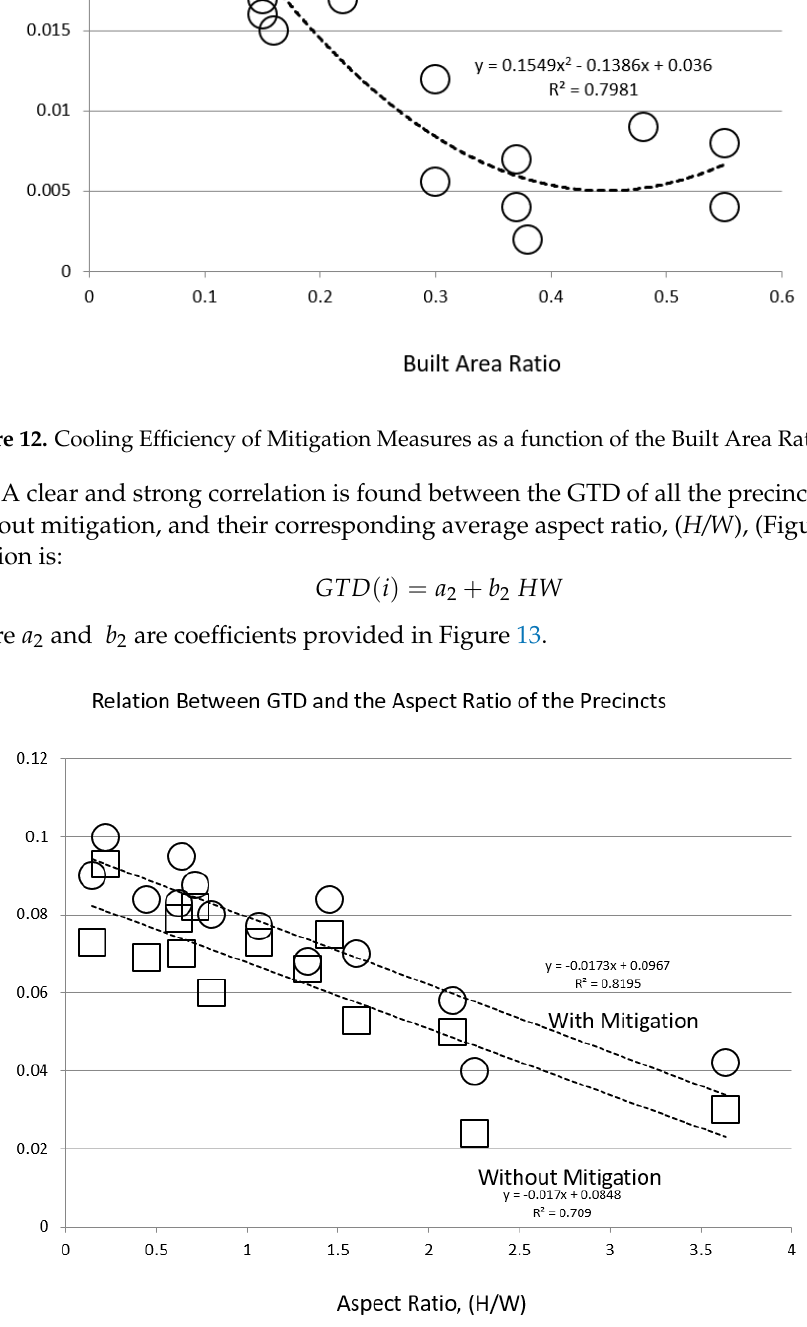
Figure 13. Relation Between GTD and the Aspect Ratio of the Precincts.